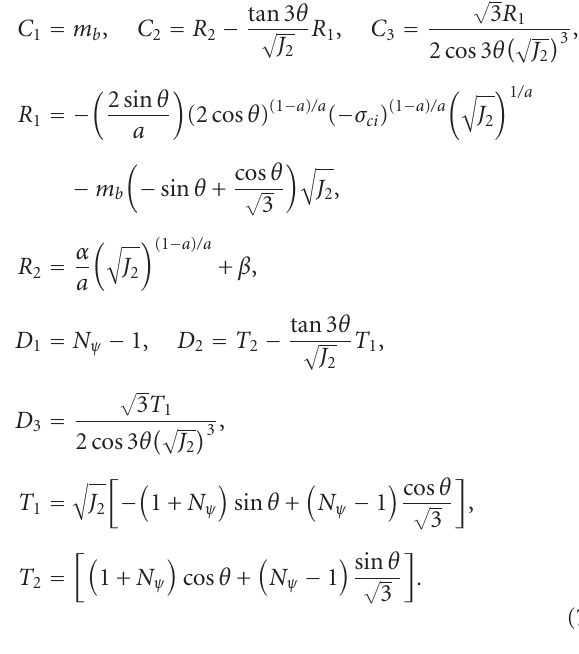
Figure 2: Yield surfaces in deviatoric